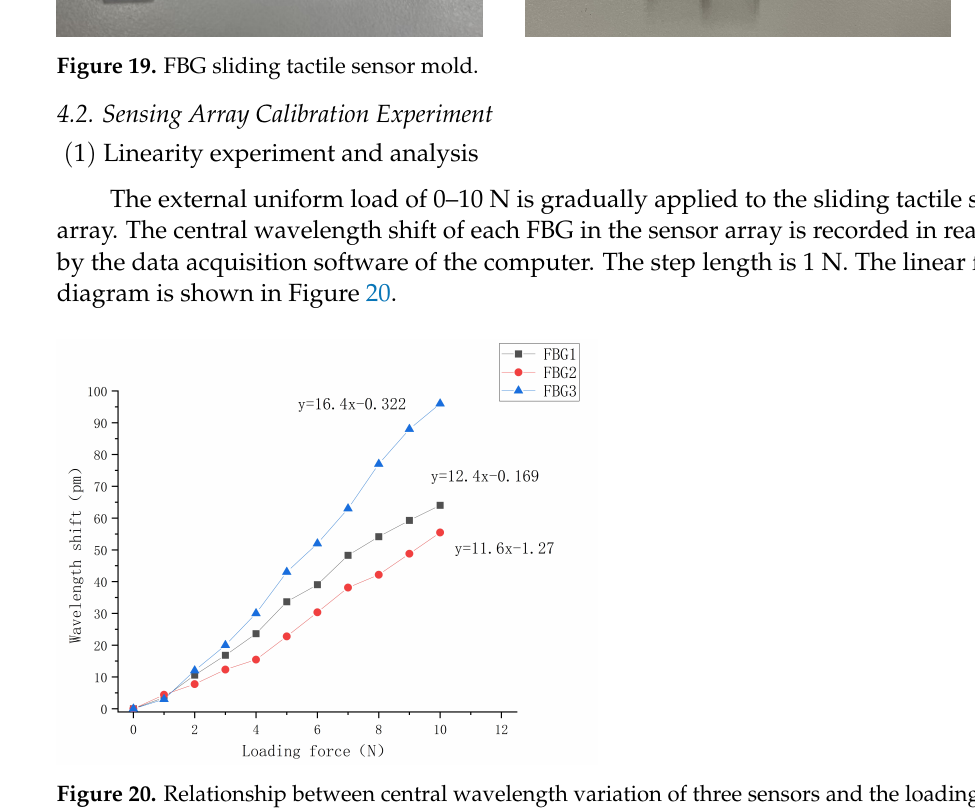
Figure 20. Relationship between central wavelength variation of three sensors and the loading